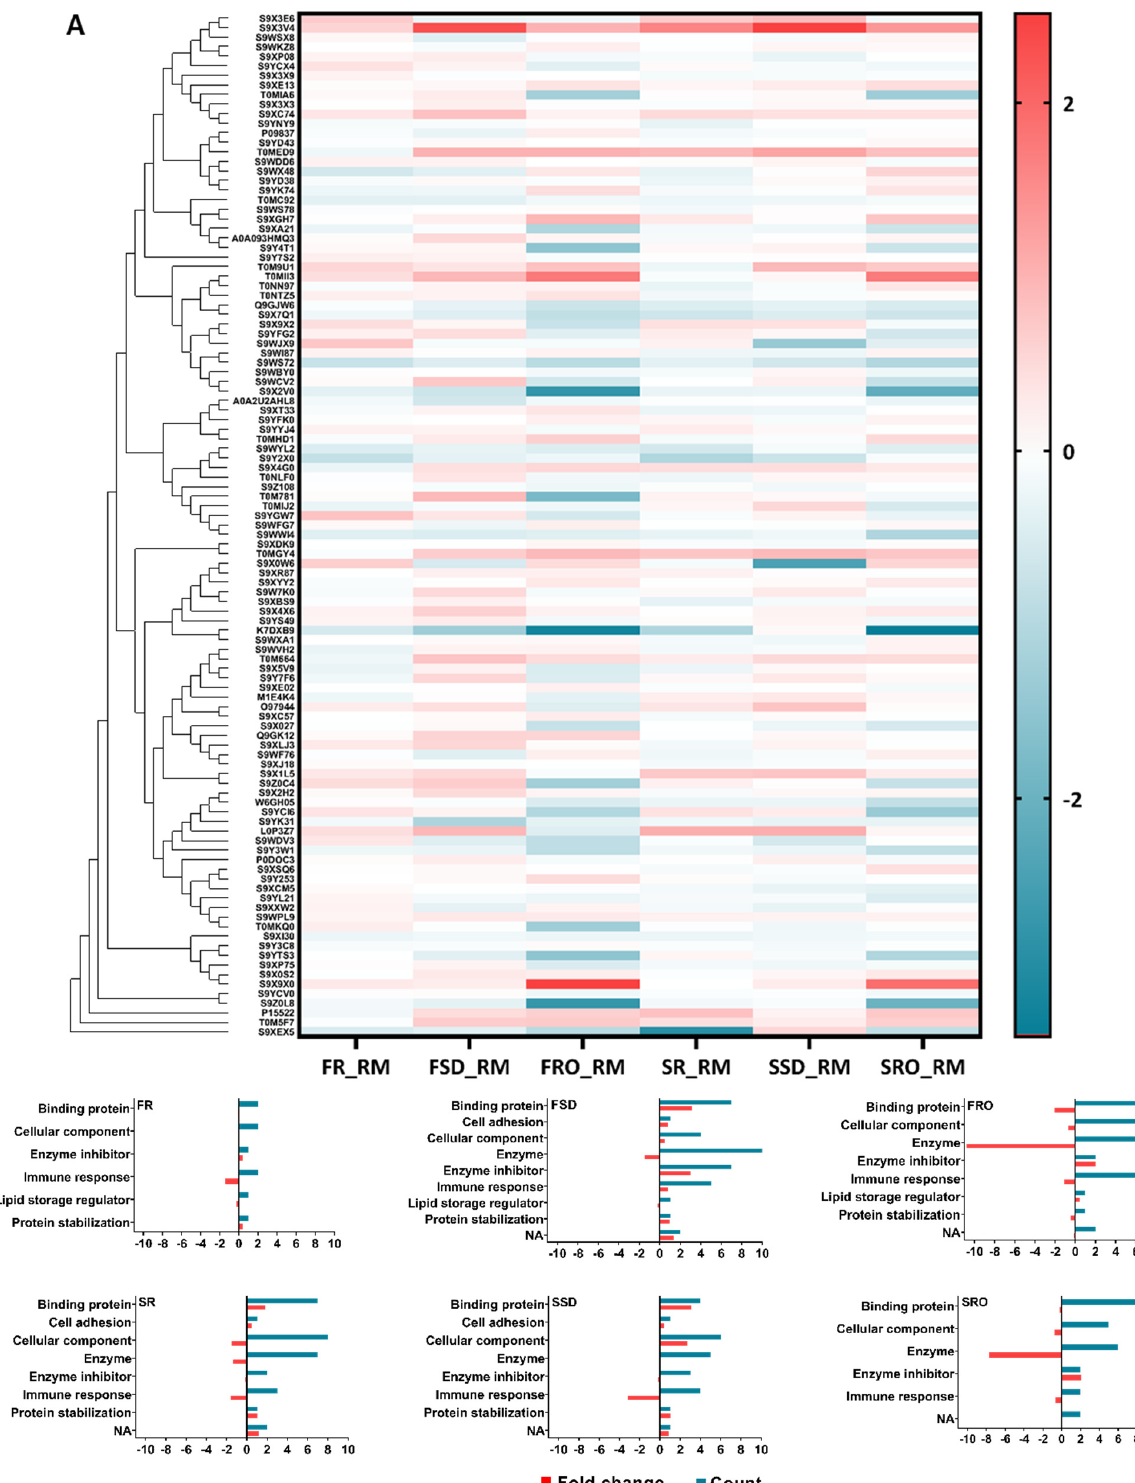
Figure 5. Heat map of abundance change of the proteins quantified in all the samples ( A ) and annotation of significantly changed proteins ( B ). Values shown as log2 (fold change) for proteins. RM, raw milk; FR, freeze-dried raw milk powder; FSD, spray-dewatering-concentrated/freeze-dried milk powder; FRO, reverse-osmosis-concentrated/freeze-dried milk powder; SR, spray-dried raw milk powder; SSD, spray-dewatering-concentrated/spray-dried milk powder; SRO, reverse-osmosis-concentrated/spray-dried milk powder.